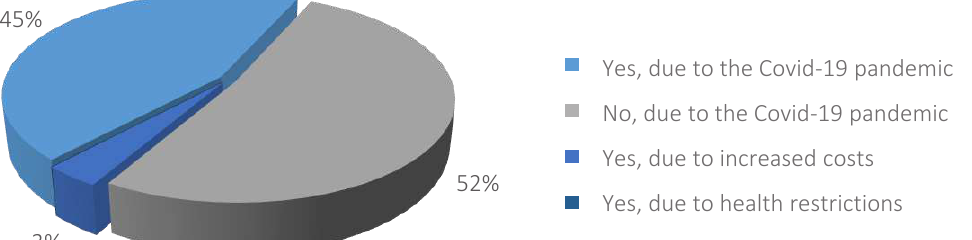
Figure 9. Has your trip duration changed?